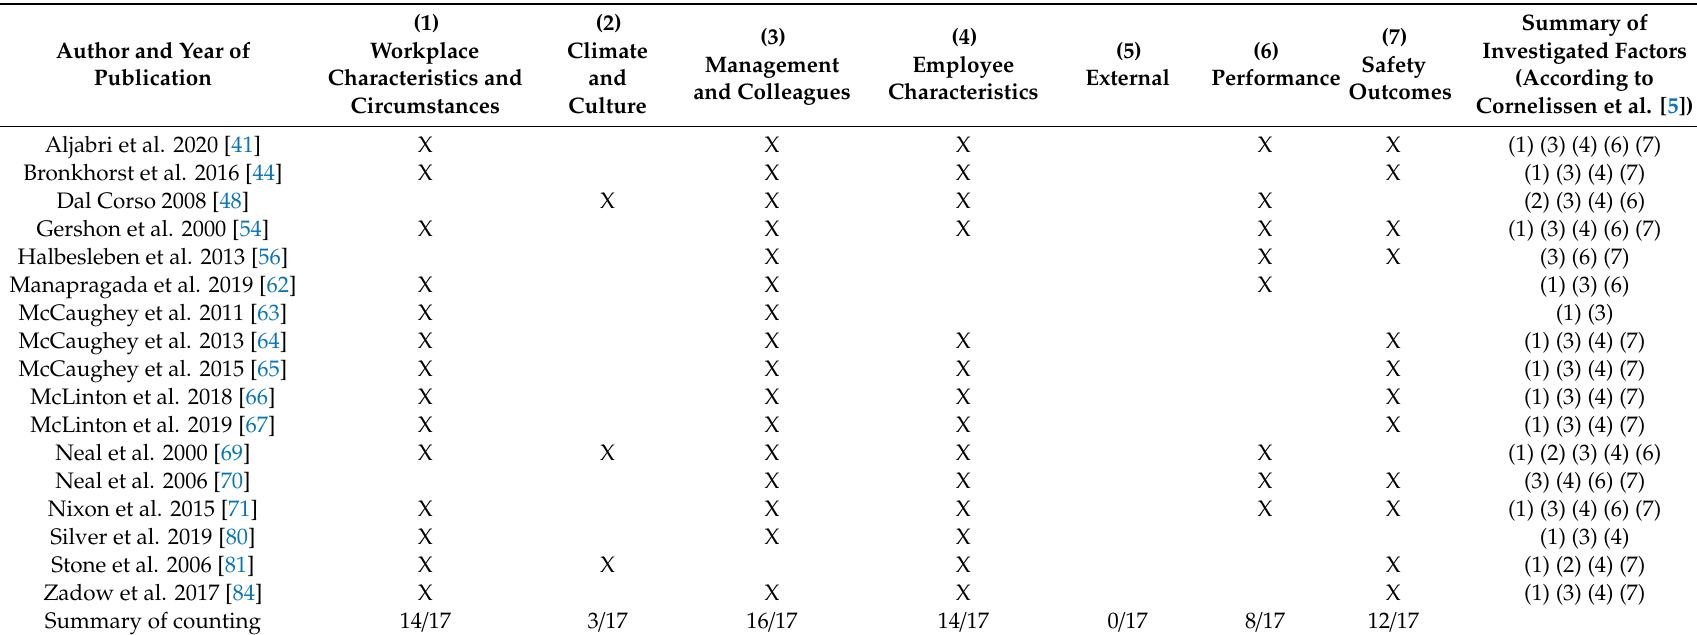
Table 2. Hospital workplaces—17 studies—mapping of the investigated determinants to clusters according to Cornelisson et al. [5] (for details of the studies see Table S5 in supplementary material, for topics and categories of the clusters see Table